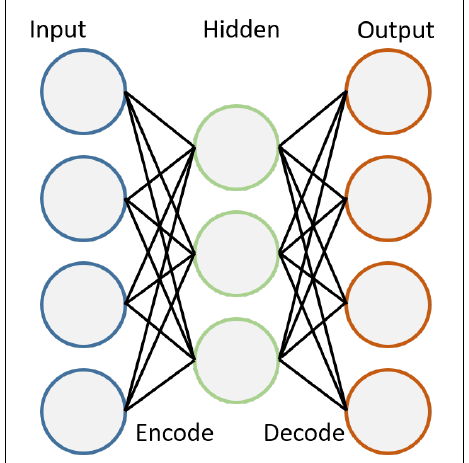
Figure 1. Autoencoder